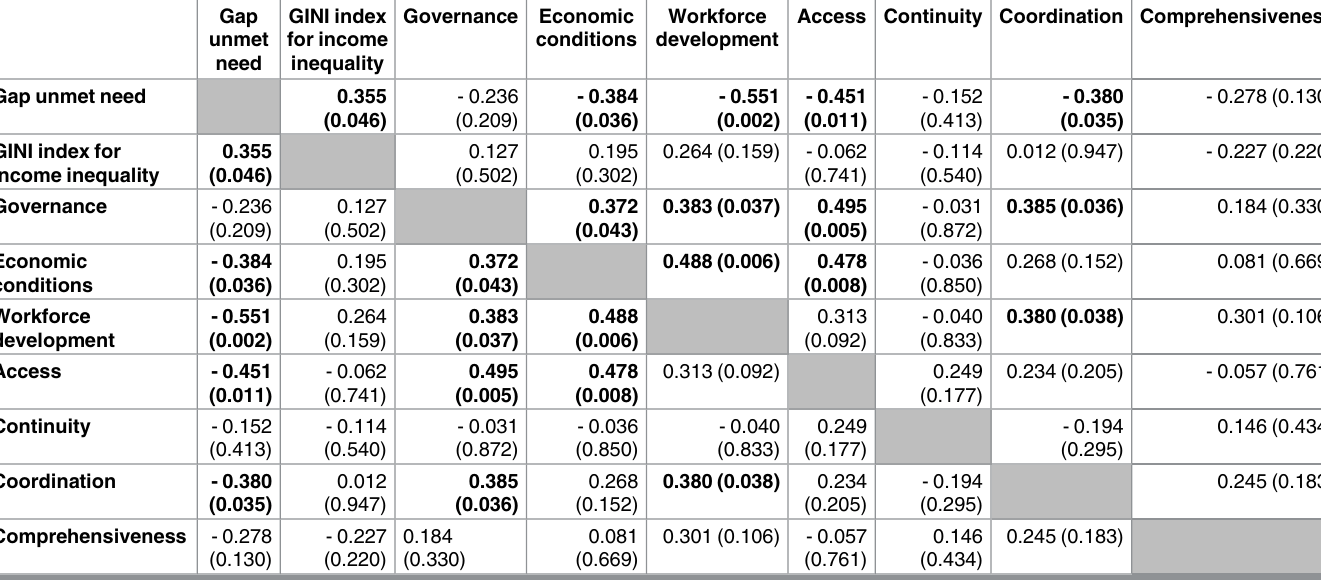
Table 3. Correlation matrix between the dependent variable and all independent